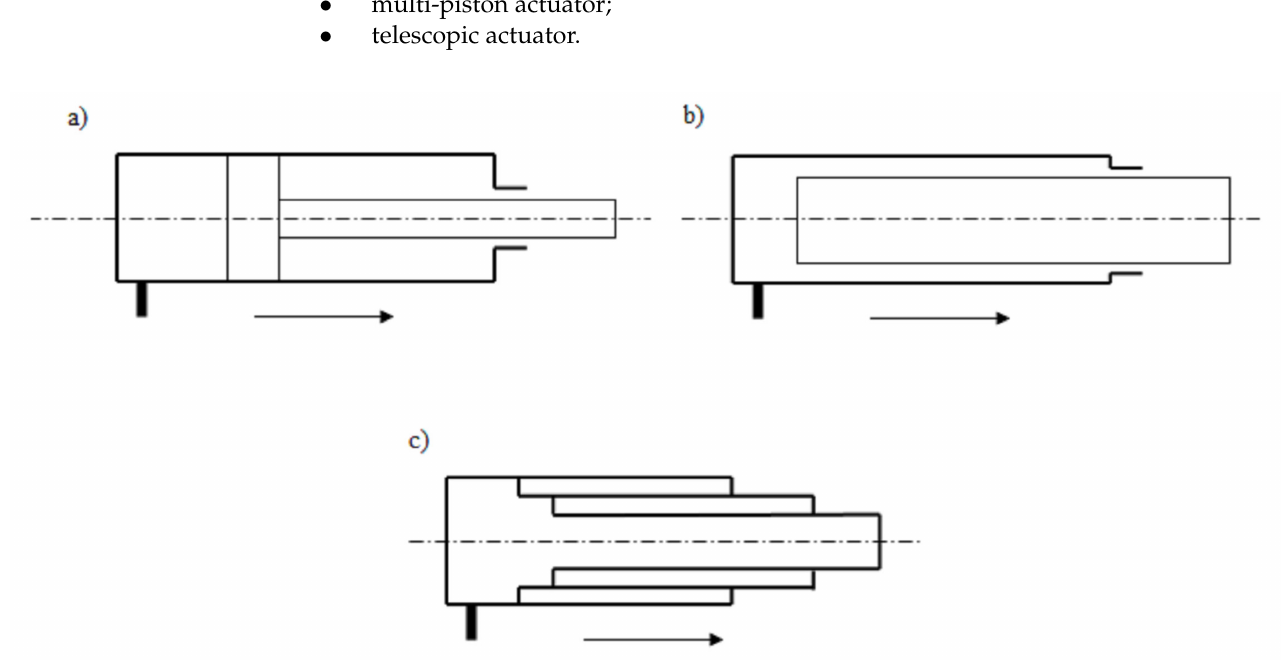
Figure 1. Types of single-acting actuators: ( a ) piston, ( b ) plunger, ( c ) telescopic.